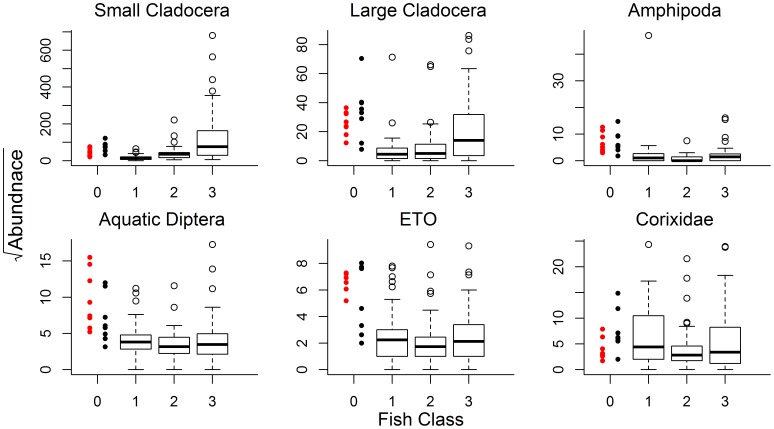
Aquatic invertebrate abundance among lakes with different fish communities.Box plots depicting relative abundance patterns for each of 6 invertebrate response variables (ETO = Emphemeroptera+Trichoptera+Odonata). Fish class indicates fish absence (value = 0) or whether community contained only planktivores (value = 1), planktivores +benthivores (value = 2), or planktivores+benthivores+piscivores (value = 3). Abundance estimates for fishless lakes include supplemental data (values in red = 1999; black = current study) and are included to allow comparisons with fishless lakes. See text for more explanation.